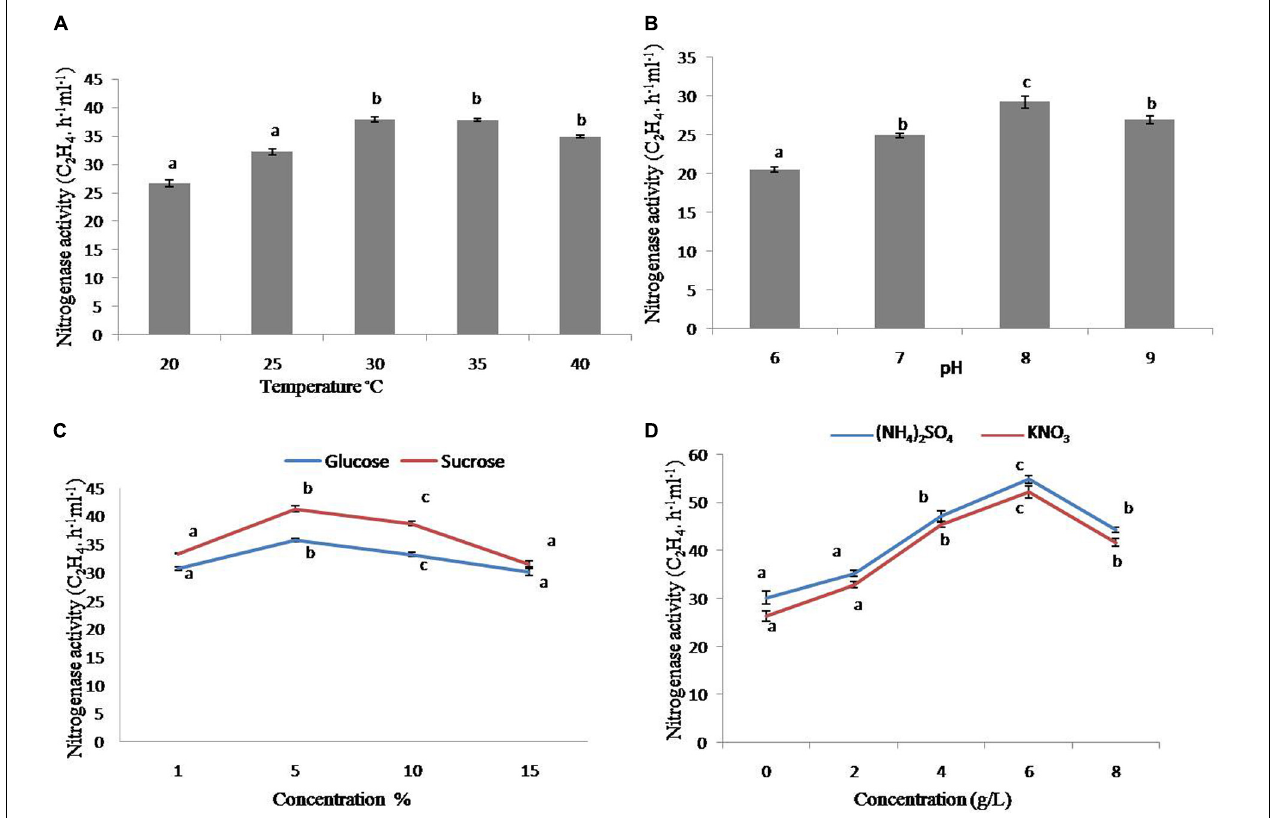
FIGURE 2 | Nitrogenase activity of strain GXS16. (A) Temperature, (B) pH, (C) Glucose and sucrose, (D) (NH 4 ) 2 SO 4 and KNO 3 . Values are mean, and vertical bars indicate the standard deviation of three replications. Means followed by the same letter within a column are not significantly different ( p < 0.05) according to Duncan’s multiple range test